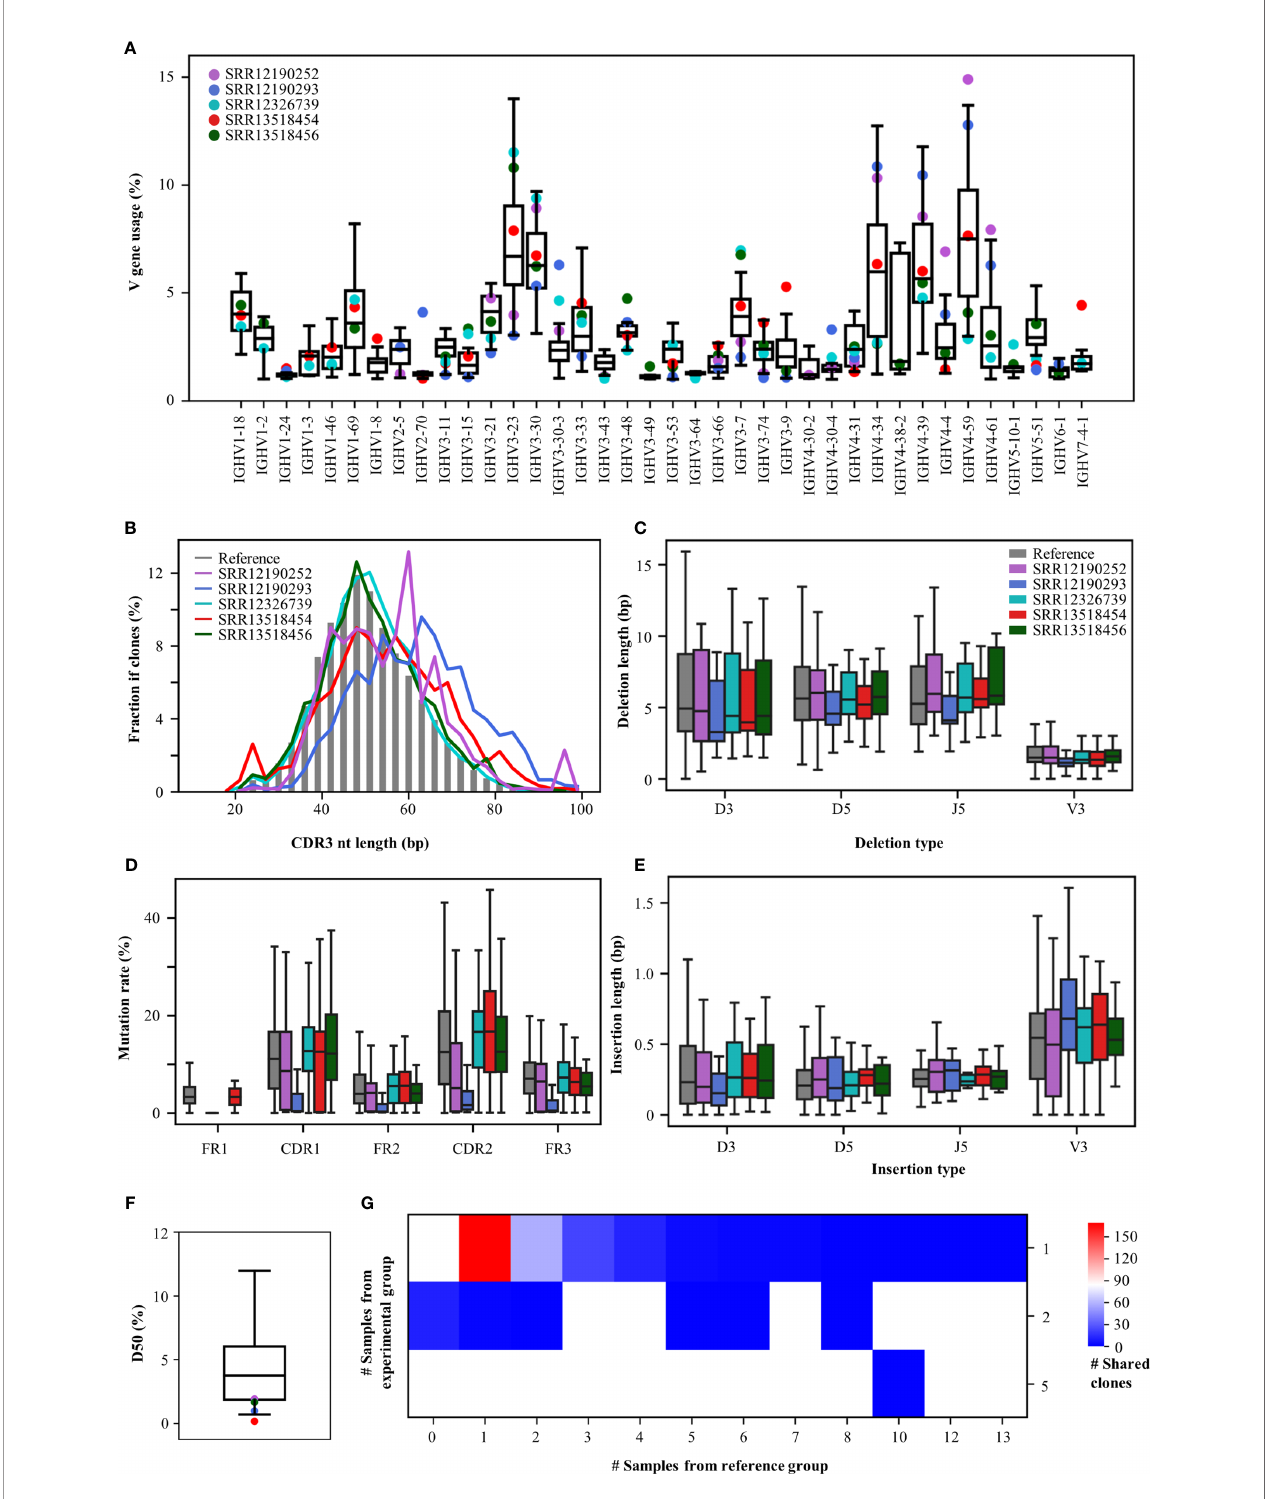
FIGURE 3 | Repertoire features of COVID-19 patients compared with 32 references. (A) The distribution of V gene usage. The V-gene usage of the reference group is shown in the boxplot, and that of COVID-19 patients is indicated by the dots. (B) Length of CDR3nt sequences. The median fraction from the reference is indicated by the gray bars. The length of deletions (C) and insertions (E) at V3, D5, D3, and J5. (D) Mutation rates in each functional region. (F) The distribution of D50. (G) Number of shared clones. The X-axis indicates the number of references, and the Y-axis shows the number of COVID-19